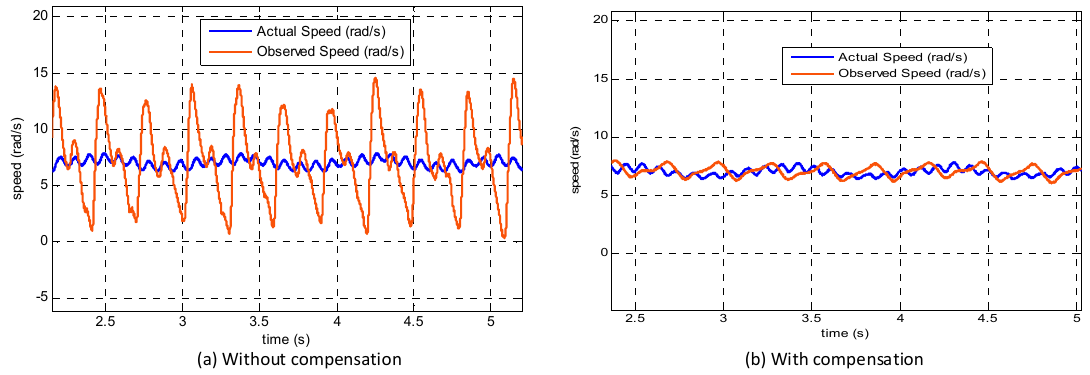
Figure 13. The experimental results of actual speed and observer speed at 7 rad/s.